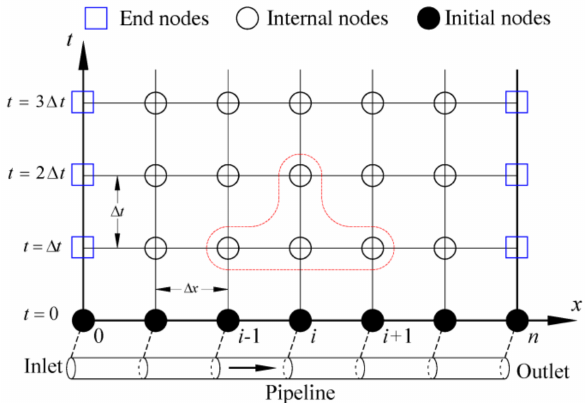
Figure 1. Meshes and node